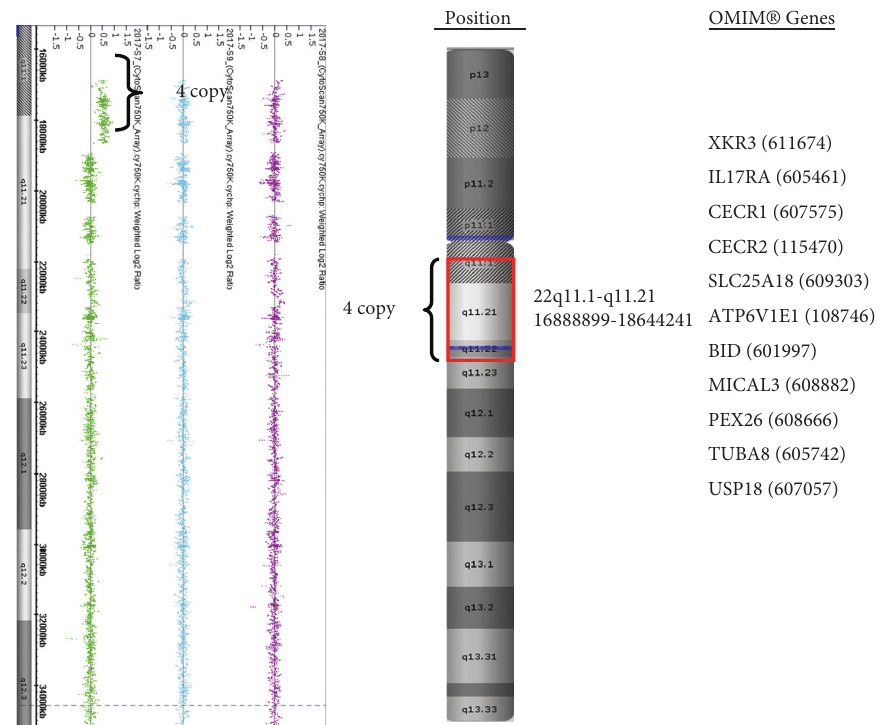
Figure 3: Results of high-resolution chromosome microarray analysis. Table 1: Known protein coding genes and their function in the 22q11.1q11.21 (16,888,899–18,644,241), 1.76Mb duplicated CES region